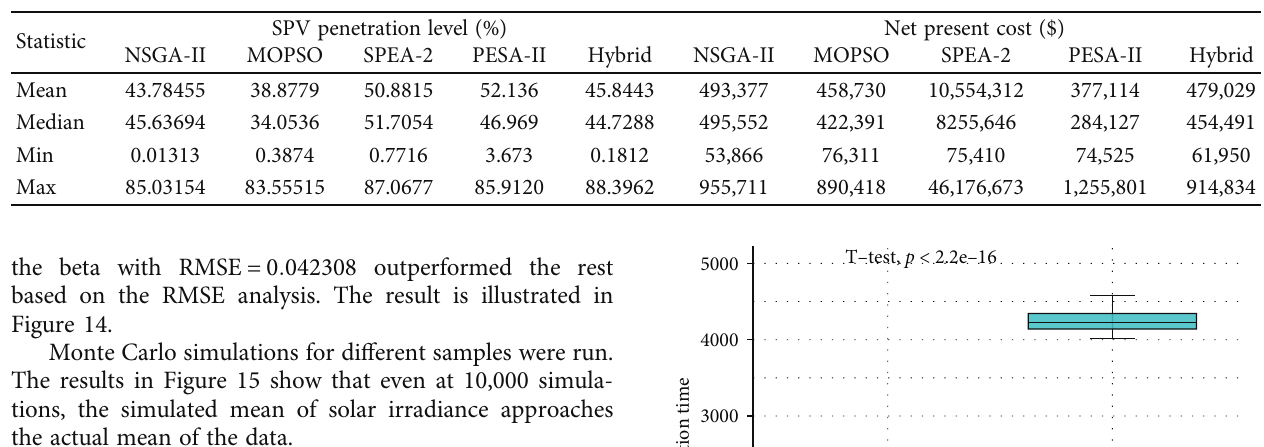
Table 6: Comparison of the hybrid algorithm with four other standard MOEAs based on the accuracy of the SPV penetration level and net present cost.